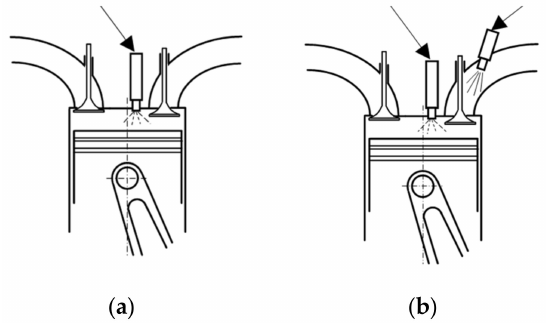
Figure 1. Power systems of dual fuel engine, ( a ) supply by blend of fuels, ( b ) supply by two separate